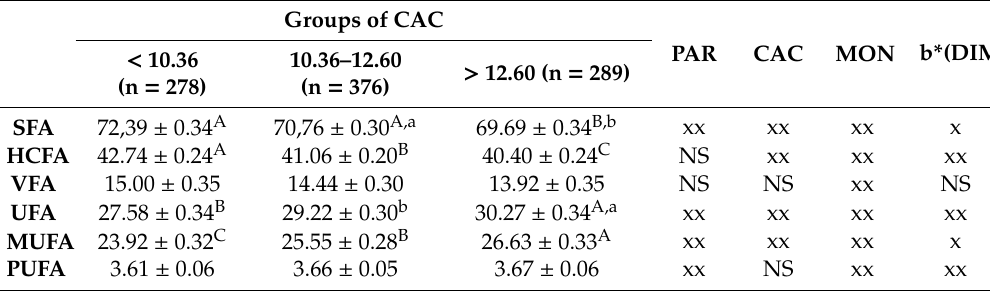
Table 2. E ff ects of citric acid (CAC) groups on fatty acids group concentrations (LSM ± SELSM) and significance of e ff ects in model